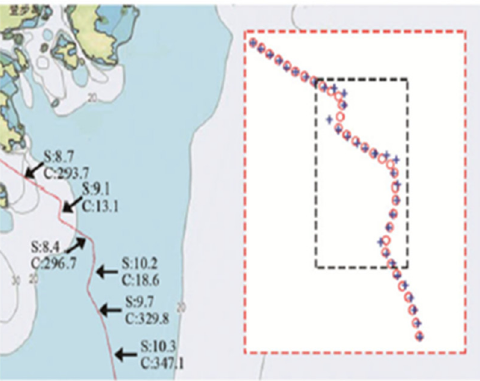
Figure 8. Anomalies in vessels’ course [36].